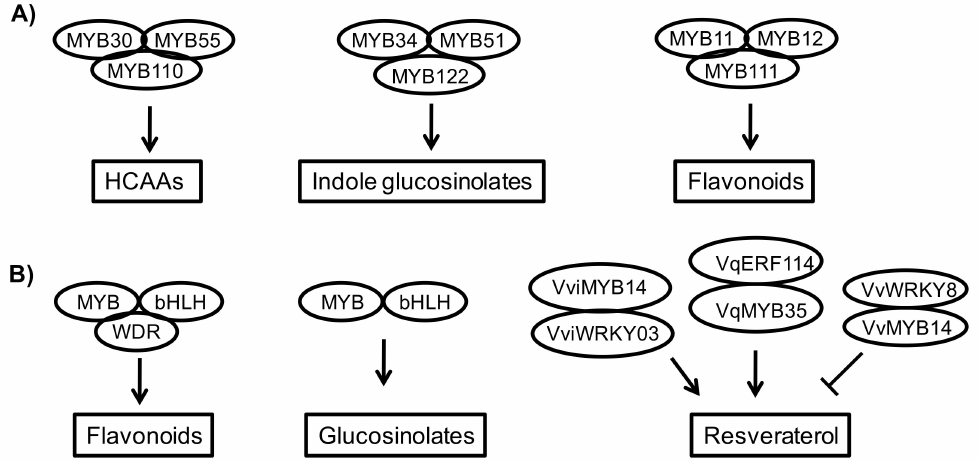
Figure 2. Protein interaction of transcription factors in the regulation of secondary